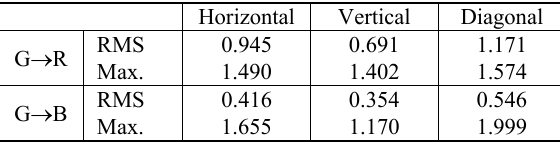
Table 1. RMS and maximum of displacements caused by chromatic aberration of 3600 evaluation points (unit: pixel) Figure 4 shows displacement vectors G  R and G  B in the uncompressed R+G+B data of the image shown in Figure